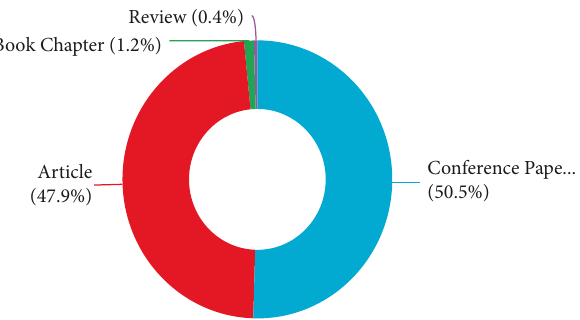
Figure 3: Distribution of document types for PSOA research publications